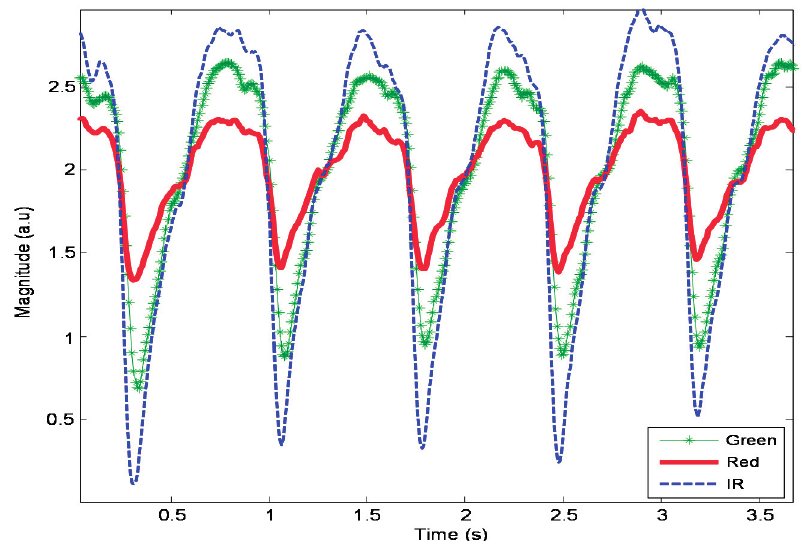
Figure 11. Photoplethysmography (PPG) signals captured by the OEPS with three wavelength illuminations .